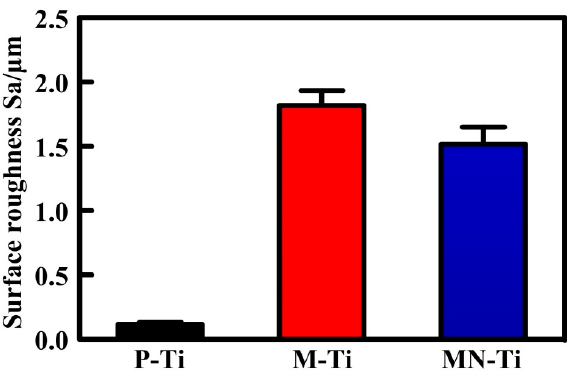
Figure 5. The surface roughness of P-Ti, M-Ti, and MN-Ti. Error bars represent means ± SD for n = 5.